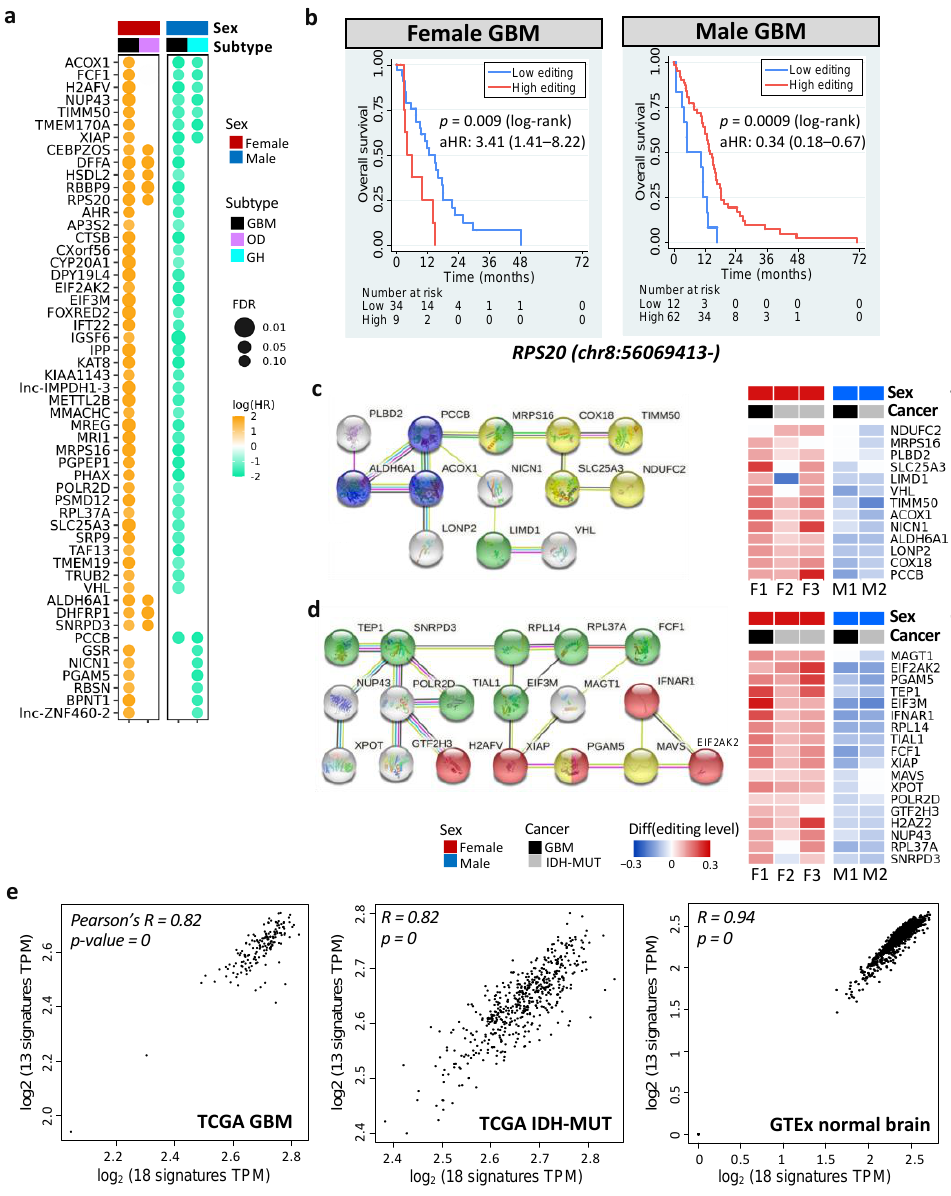
Figure 6. Prognostic and editing-regulated genes in glioma. ( a ) Age-adjusted hazard ratios (aHRs) of prognostic genes shared by both sexes or at least two cancer types (FDR < 0.15). GH: astrocytoma with high levels of DNA methylation; OD: oligodendroglioma. ( b ) Kaplan–Meier curves and aHR for editing levels of chr8:56069413- ( RPS20 ), which is prognostic in both female and male GBM tumors. High vs low: top 30% vs bottom 70% for females and top 70% vs bottom 30% for males. ( c ) and ( d ) represent PPI networks (left) and editing differences between high- and low-risk gliomas (right) of prognostic, editing-regulated genes. Comparisons are made for GBM (F1: G 2 vs G 1 and M1: G 1 vs G 2 ) and IDH-MUT gliomas (F2: GH vs ODI 1 ; F3: ODI 2 vs ODI, and M2: GHI 1 vs GHI 2 ). Colors indicate enriched biological process (blue: propanoate metabolism, FDR = 0.0008; red: necroptosis, FDR = 0.0001) and cellular localization (yellow: ribonucleoprotein complex, FDR = 0.003; green: mitochondrial membrane, FDR = 0.006). ( e ) Scatterplots of gene expressions of the two networks in TCGA GBM tumors (left), TCGA IDH-MUT tumors (middle), and normal brain tissues from GTEx (right). X-axis represents genes in ( d ) and y-axis represents genes in ( c ).